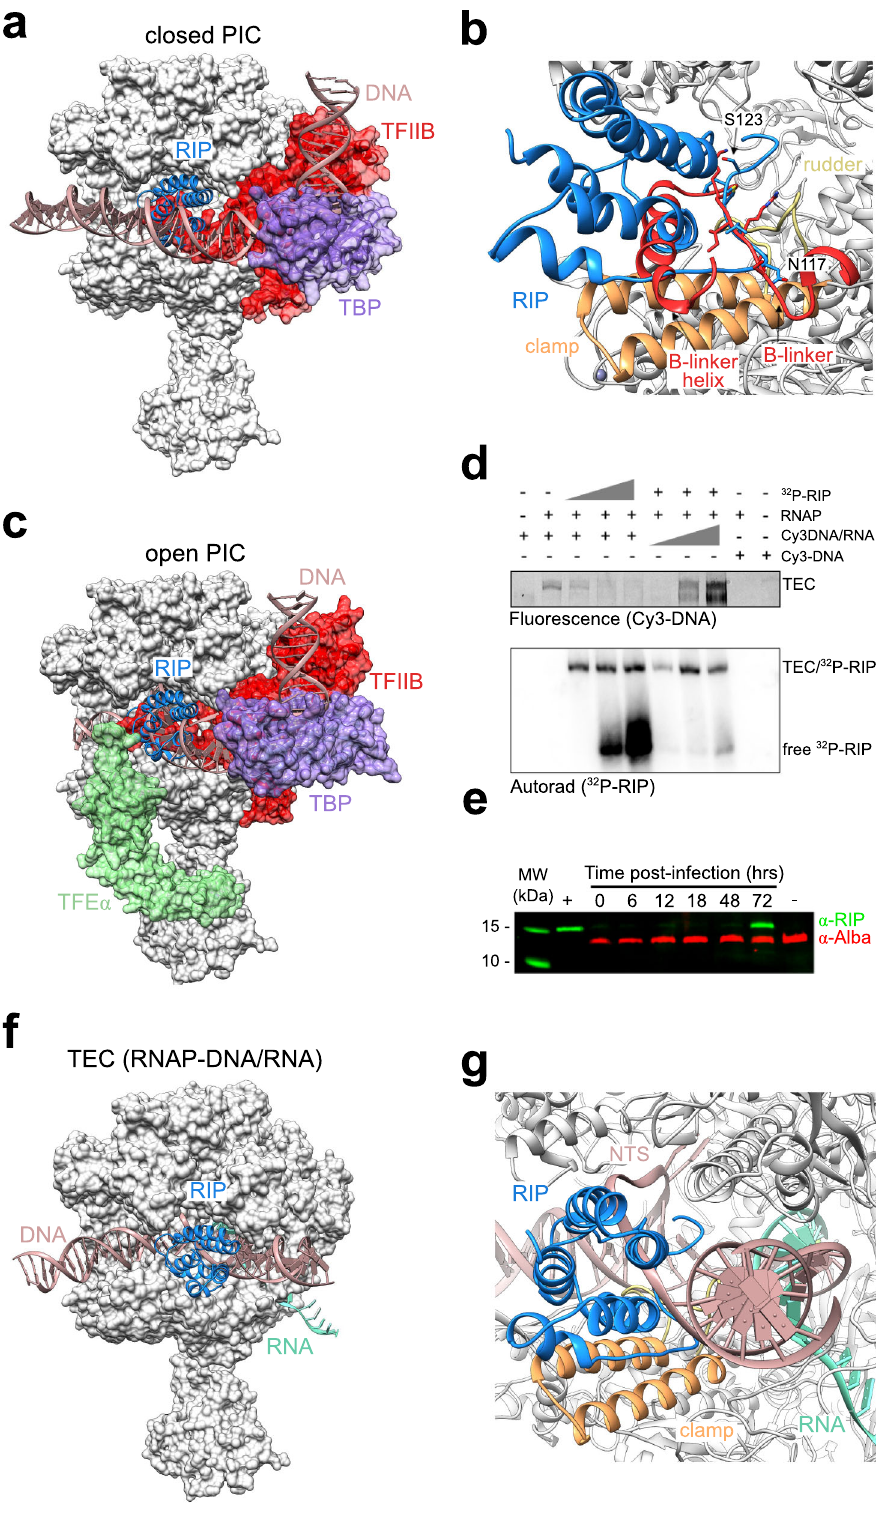
contribution of the NTS clash to the inhibition, we carried out EMSA experiments with dual labelled components; RIP was radiolabelled using 32 P while the DNA/RNA elongation scaffold was labelled with the fl uorescent dye Cy3 on the DNA template strand. The low mobility bands detected by the fl uorescence signal in the upper panel of Fig. 3d correspond to bona fi de TECs. The addition of 32 P-RIP counteracts the Cy3-TEC signal in a